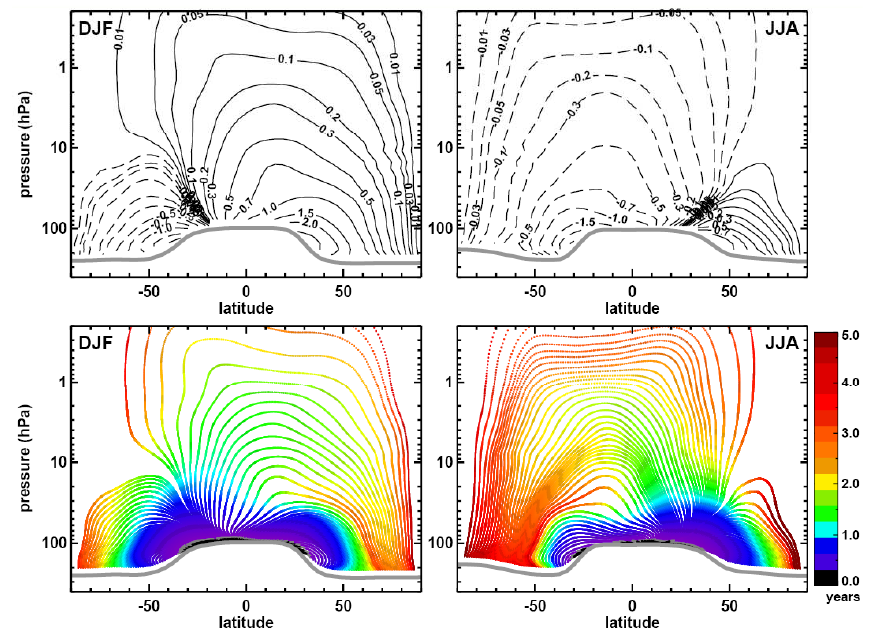
Fig. 1. (Top) Seasonal mean residual streamfunction (divided by a , in 10 2 kg/m/s, negative values dashed) for CMAM. Note irregularly spaced contours. (bottom) Trajectories along fixed residual streamlines and their associated transit times (colour coding, years). Only trajectories arriving poleward of 30 ◦ are plotted. Left panels: boreal winter, right panels: boreal summer. Thick gray lines mark average tropopause pressure in all panels.